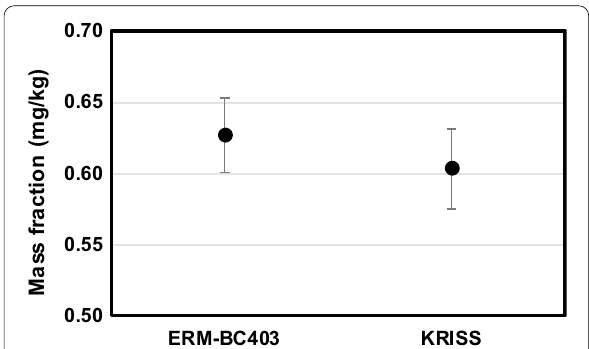
Fig. 4 Graphic illustration of agreement between the certified value and the measured value by the developed ID-LC/MS/MS method for ERM-BC403 cucumber sample